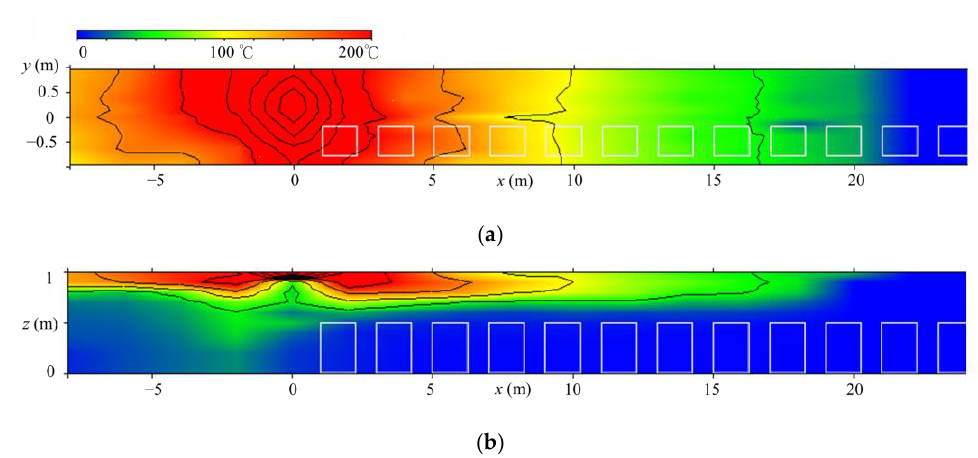
Figure 10. Experimental results of the temperature distribution in the central longitudinal section; Q m = 161 kW, U m = 0.421 m/s, t = 200 to 260 s: ( a ) z = 0.98 m; ( b ) y = 0.